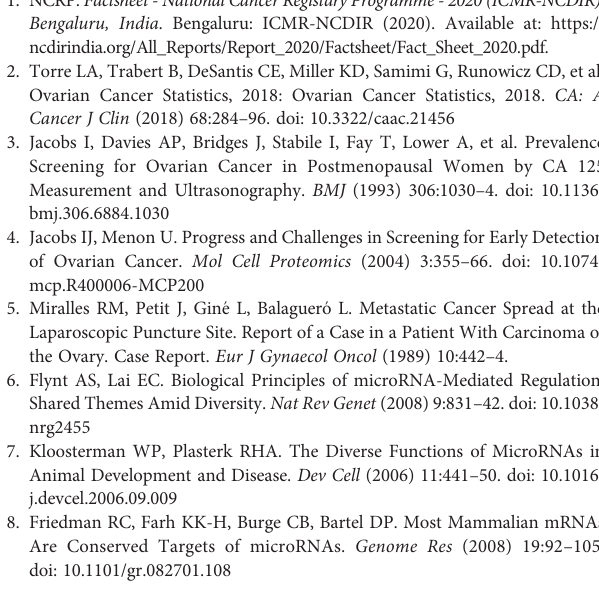
miR-205, miR-200c and miR-141 was signi fi cantly elevated in cancer compared to control with fold change of 3.85 (p < 0.05), 4.95 (p < 0.05), and 4.69 (p < 0.05), respectively. Supplementary Figure 2 | Represents expression of miRNA in different FIGO stages of epithelial ovarian cancer. (A) In tissue cohort {n=85 (41 stage-I+II and 44 stage-III+IV)}, expression levels of miR-205, miR-200c and 141 were signi fi cantly elevatedincombinedstage III-IV(P=0.05;P<0.005;P<0.005respectively), (B) In serum cohort {n=51 (21 stage-I+II and 30 stage-III+IV)}, relative expression of miR- 205, miR-200c and miR-141 was signi fi cantly elevated in stage III-IV (P < 0.05, P < 0.005, P < 0.005 respectively). Statistically signi fi cant differences were determined by the One-way ANOVA test and Mann Whitney U-tests. Data represent mean ± standard error on the mean (SEM). *P < 0.05; **P < 0.01; ***P < 0.0001; ns, not signi fi cant. Supplementary Figure 3 | Represents expression of miRNAs in different histotypes of epithelial ovarian cancer. (A) In tissue cohort (n=85 cancerous sample), expression levels of miR-205 was able to signi fi cantly discriminate mucinous from other subtypes of EOC (P <0.005). Similarly, miR-200c was signi fi cantly elevated in endometrioid subtype (p < 0.005) while, miR-141 signi fi cantly elevated in serous subtypes (p < 0.05) to compared histotypes (B) In serum cohort (n=45 cancerous sample), relative expression of miR-205, miR-200c and miR-141 were not changed in subtype EOC. Statistically signi fi cant differences were determined by the One-way ANOVA test. Data represent mean ± standard error on the mean (SEM). *P < 0.05; **P < 0.01; ***P < 0.0001; ns, not signi fi cant. Ser, serous; Muc, Mucinous; CC, Clear cell; Endo, Endometrioid subtype. Supplementary Figure 4 | Represents expression of miRNA in metastatic and non-metastatic samples of epithelial ovarian cancer. (A) In tissue cohort {n=85 (44 metastaticand41non-metastatic)},expressionlevelsofmiR-205, miR-200cand141 were signi fi cantly discriminating non-metastatic and metastatic cases (P <0.0001; P <0.0001; P <0.0001 respectively). (B) Similarly, in serum cohort {n=55 (30 metastatic and 21 non-metastatic)}, relative expression of miR-205, miR-200c and miR-141 was signi fi cantly elevated in metastaticcasesascompareto non-metastatic cases (P <0.001; P <0.001, P <0.001 respectively). Statistically signi fi cant